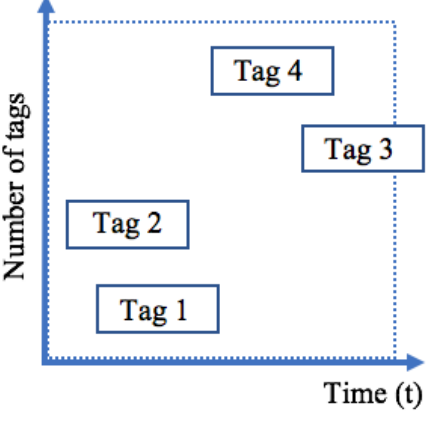
Figure 6. Code Division Multiple Access (CDMA) procedure.